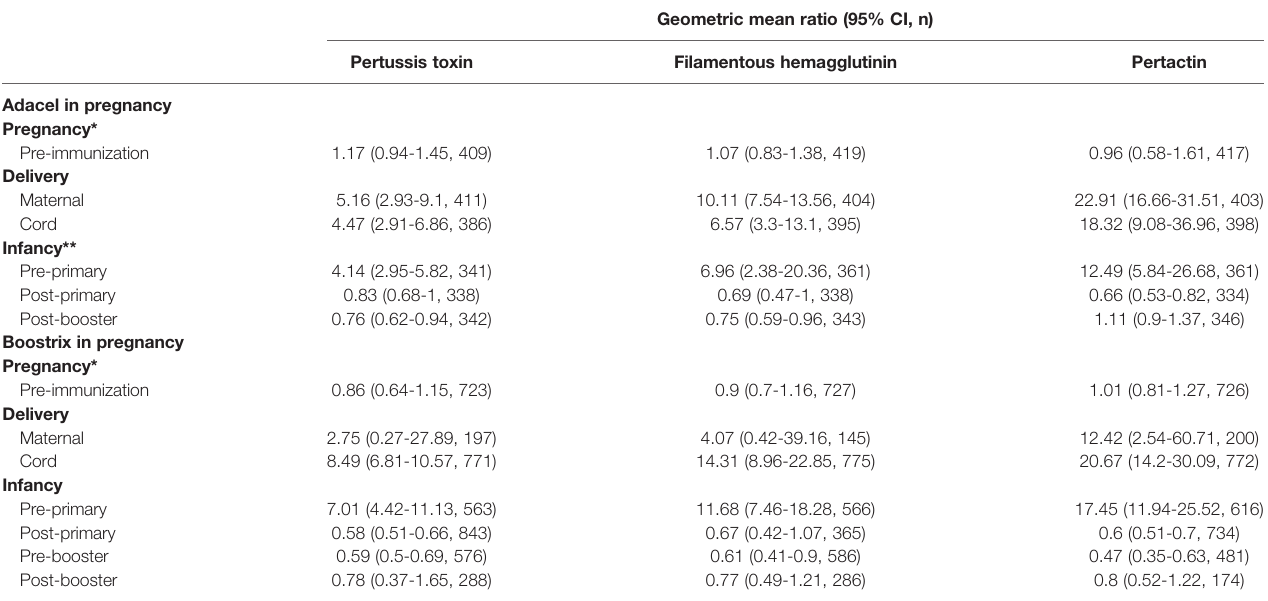
TABLE 2 | Geometric mean ratio of anti- Bordetella pertussis IgG levels in women immunized with tetanus-diphtheria-acellular-pertussis (Tdap) versus women who did not receive Tdap in pregnancy and their infants strati fi ed by type of vaccine administered in